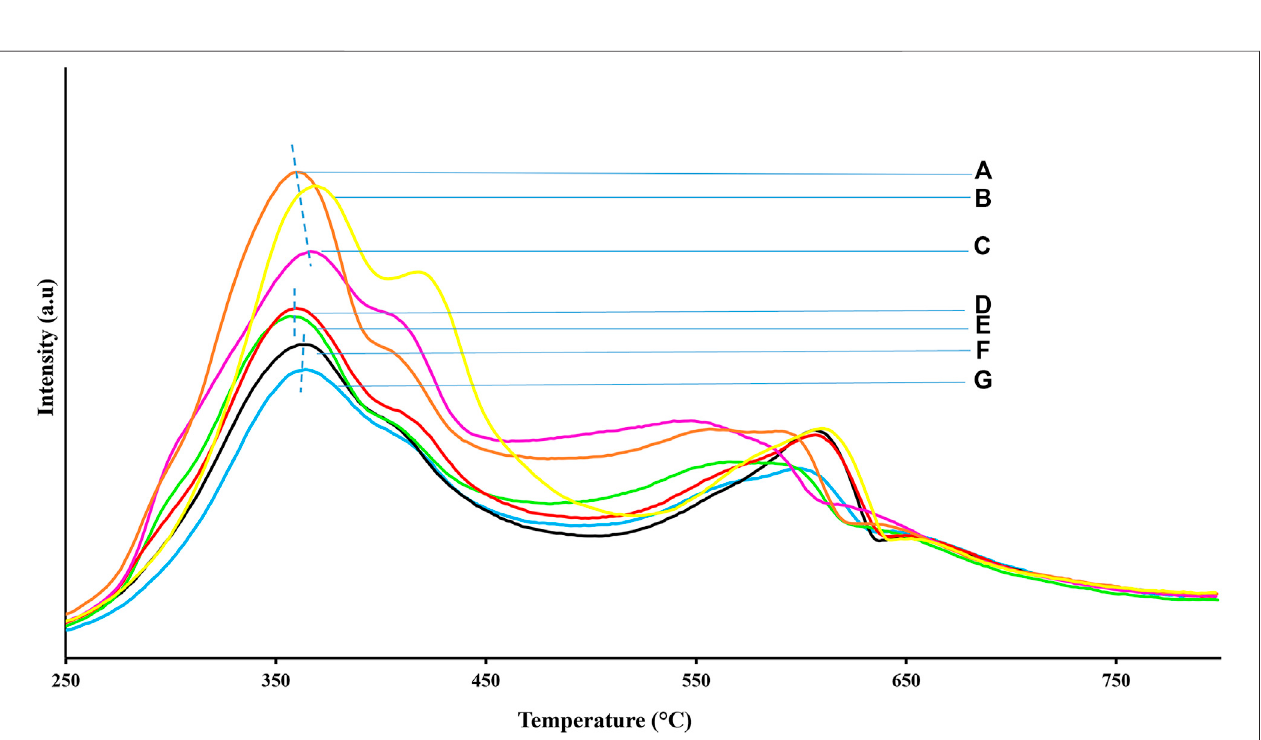
FIGURE6| TPRresultsofNiMo/OCP f catalysts; (A) 5.0wt%Ni19wt%Mo/OCP f , (B) 5.0wt%Ni26wt%Mo/OCP f , (C) 5.0wt%Ni13wt%Mo/OCP f , (D) 3.5wt%Ni19wt %Mo/OCP f , (E) 3.5wt%Ni13wt%Mo/OCP f , (F) 2.5wt%Ni19wt%Mo/OCP f , (G) 2.5wt%Ni13wt%Mo/OCP f .